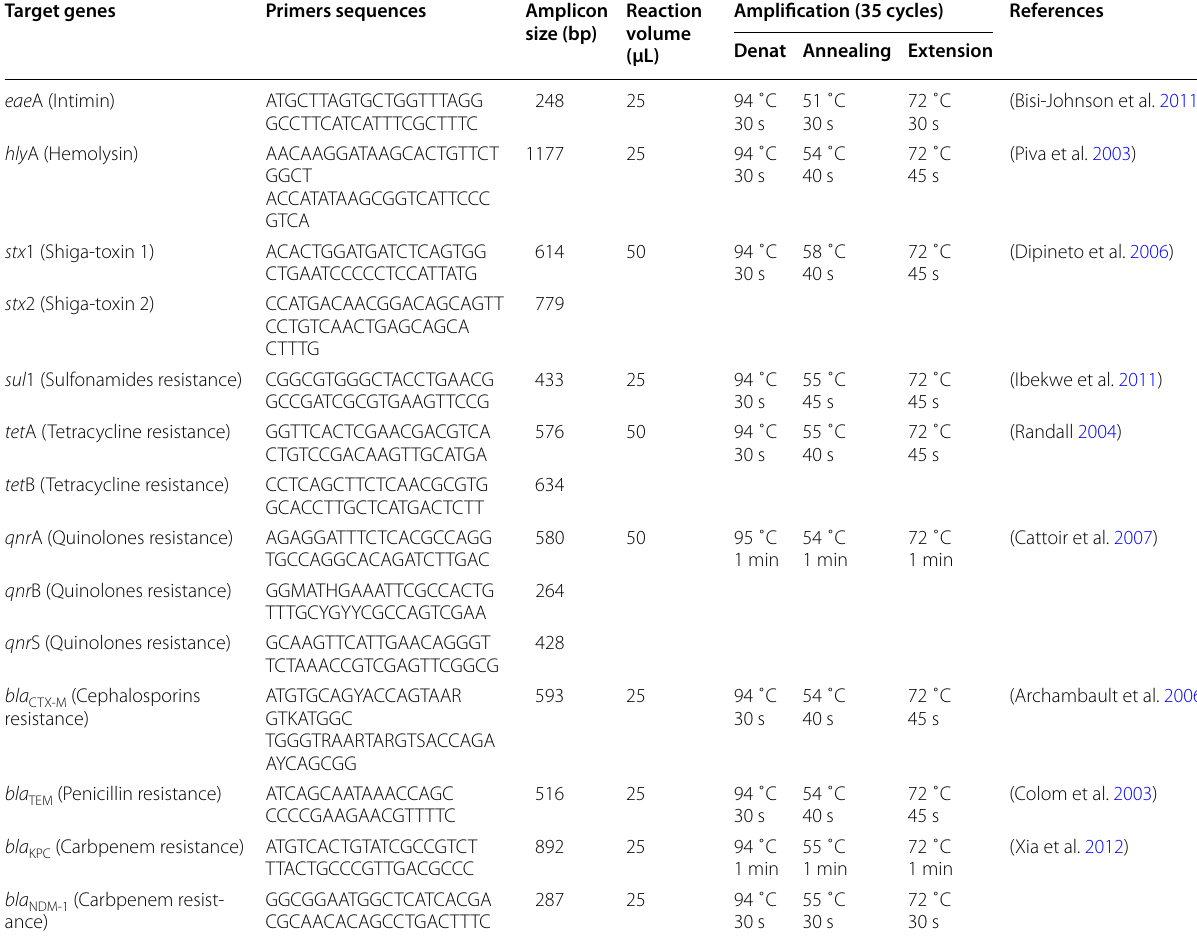
Table 1 Oligonucleotides sequences and cycling conditions of PCR assay Target